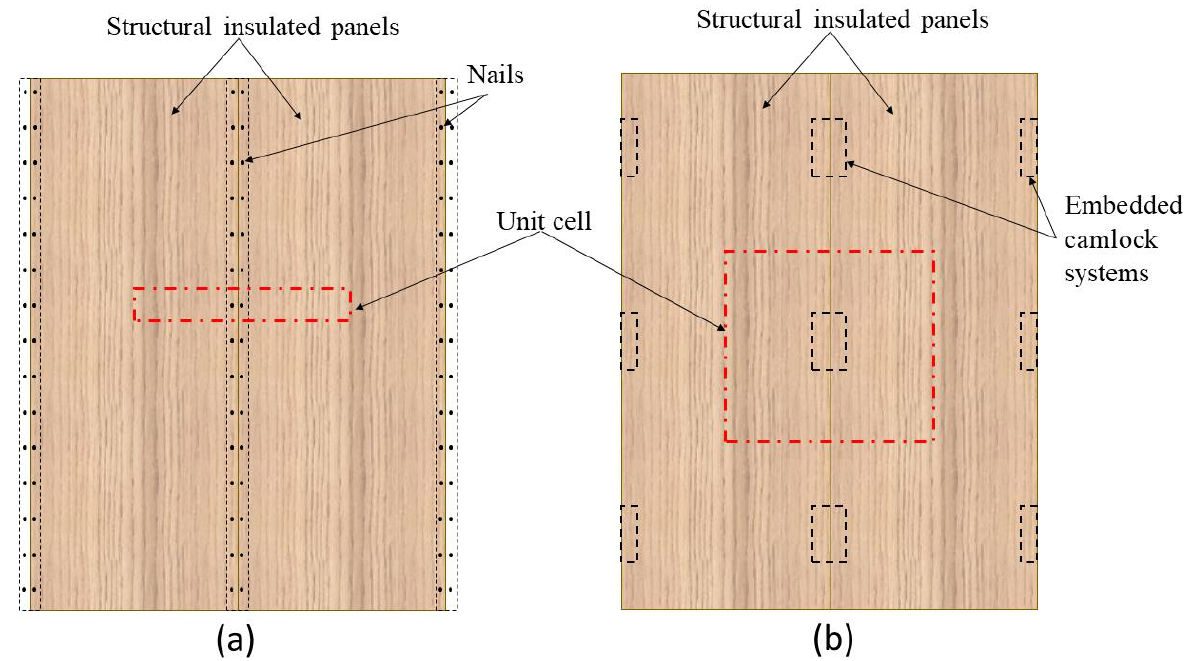
Figure 1. Schematic of SIPs connected by ( a ) surface spline and ( b ) embedded camlock systems.